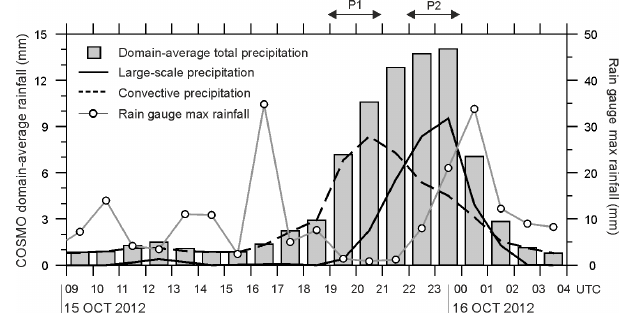
Figure 2. COSMOiso-produced domain-averaged total precipita- tion (bar), synoptic precipitation (black solid line), and convective precipitation (dashed line) in domain of southern Italy (SI) over the land during IOP 13. Temporal evolution of observed maximum rain- fall within the SI domain is shown by a line with dot. The location of domain SI is depicted by the box in Fig.